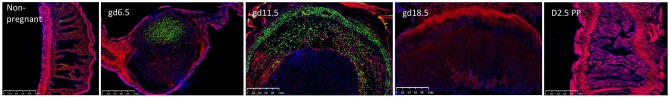
The accumulation and decline of GFP+ uNK cells in the Ncr1iCre X RosamT/mG reporter mice during pregnancy. The GFP+ uNK cells accumulate in the decidualized endometrium at gd6.5 and are found segregated to the myometrium and decidua basalis by gd11.5. At gd18.5, (laboring dam) the placenta has remnants of the MLAp and decidua basalis and is essentially devoid of uNK cells. Remarkably by 2.5 days post-partum, the structure of the uterus is remodeled and contains uNK cells. Uterine sections were derived from non-pregnant mouse, different gd's, and 2.5 days post-partum, as indicated.